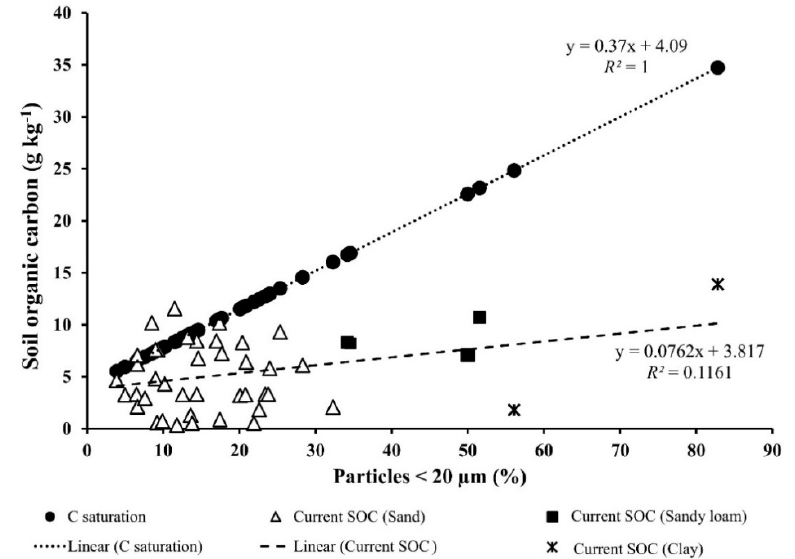
Figure 7. Relationship between C in the particle size fraction > 20 µm (g kg − 1 soil) and the percentage of particles < 20 µm in sandy soil of Northeast Thailand ( n = 45) (within the range of 0–40 cm depth) [45,50–52,54,57,61,63,65,66,68,69,81,82].